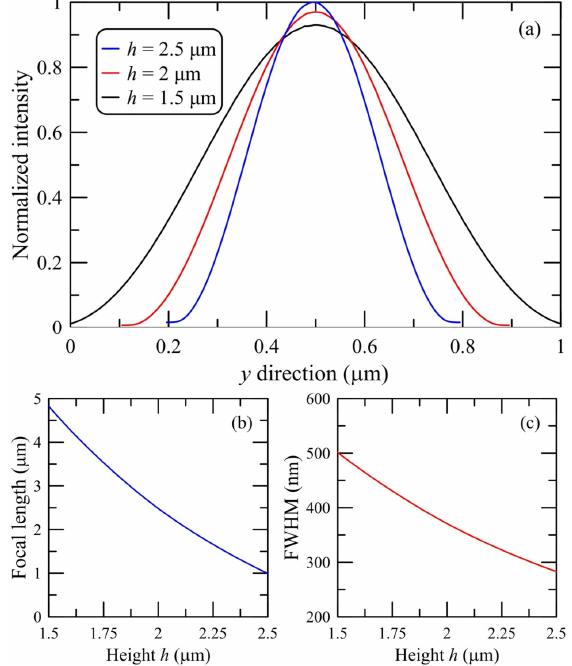
Figure 3. ( a ) Normalized intensity profiles of the photonic nanojets along the y direction for conventional triangular micro-prisms. ( b ) Focal length and ( c ) FWHM as a function of the height h of the triangular micro-prisms.